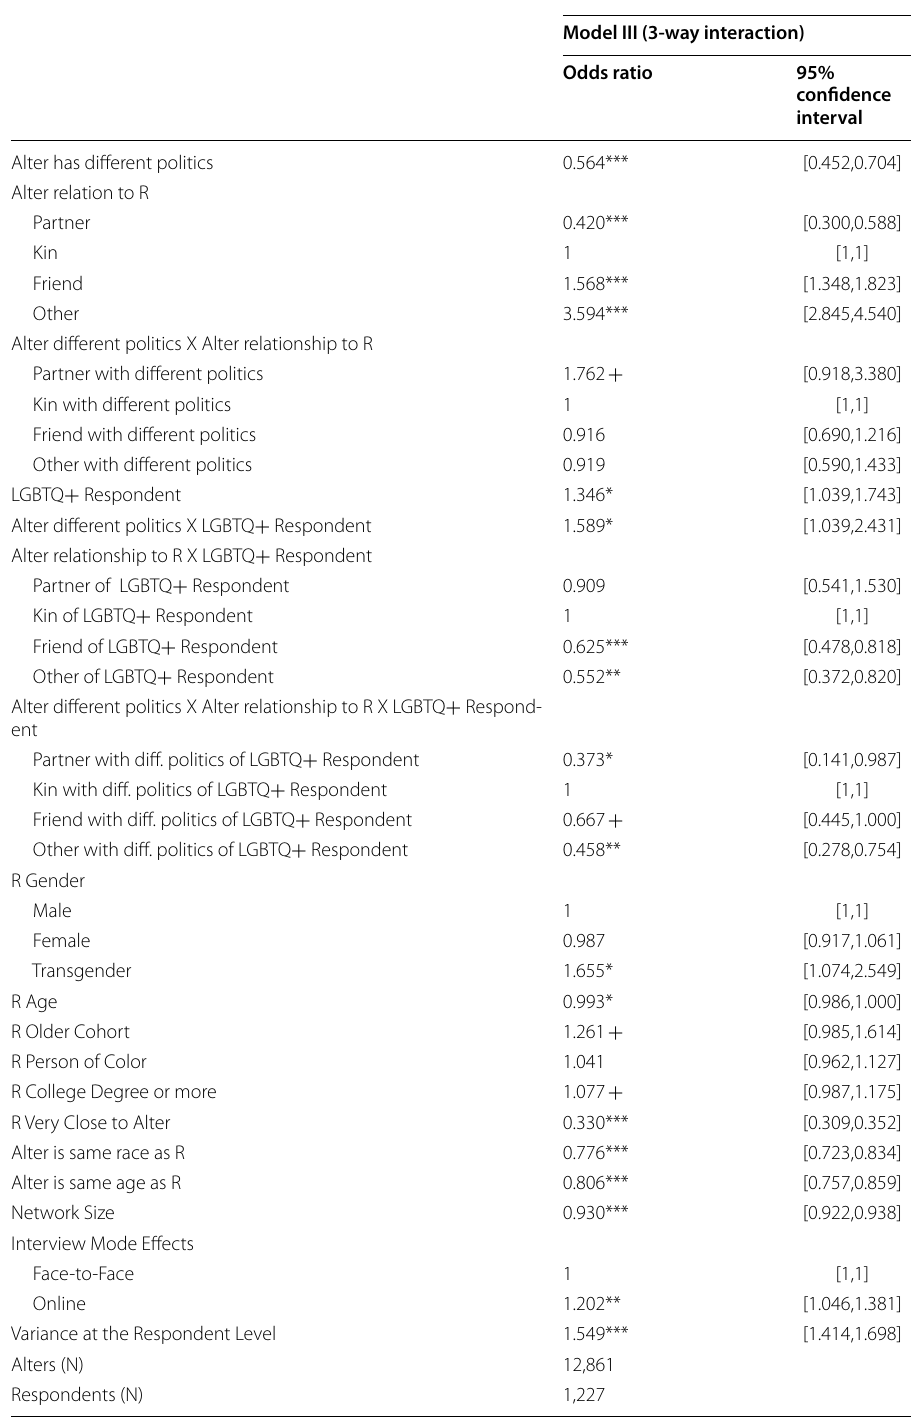
Table 6 Estimates of the likelihood of alter loss at Wave 2 with 3-way interaction by political views, relationship to respondent, and respondent sexual orientation,